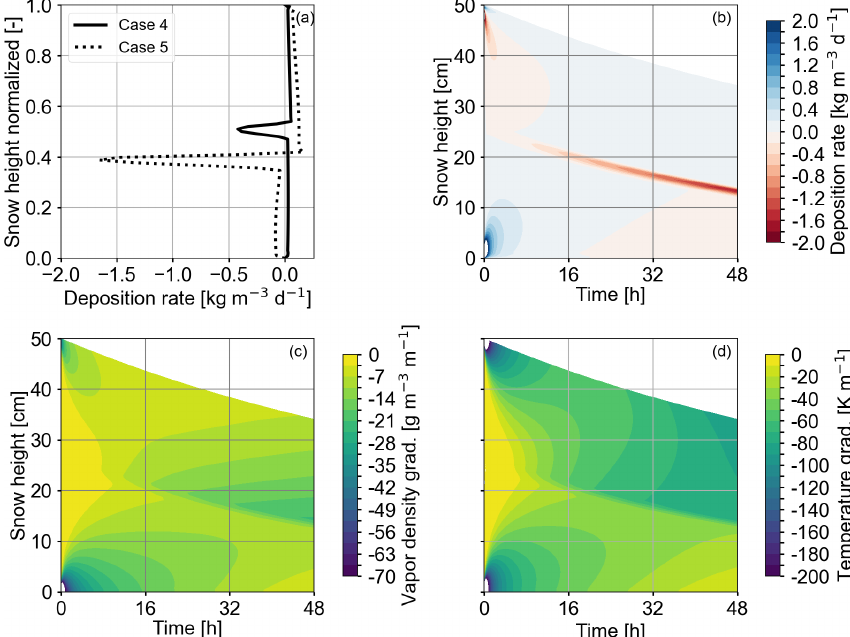
Figure 7. Panel (a) shows two deposition rate profiles over the normalized snow height after 2d. The solid line represents the results of heat and vapor transport in the absence of settling for Case 4 of Table 2. The dashed line refers to Case 5 of Table 2, which additionally accounts for settling. Sublimation rates (negative deposition rates) for Case 5 (fully coupled processes) are increased by approximately a factor of 4 with respect to Case 4 without settling. At the top of the sublimation peak for both cases, a slight peak in the deposition rate is visible. Panel (b) shows the deposition rate profile evolution for Case 5. A pronounced sublimation rate peak in the transition area is first visible after approximately 6h and increases with time. We interpret this area of increased sublimation (red line in the center) as the boundary of the upper and lower layer. Panel (c) shows the evolution of the vapor density gradient. The gradient at the bottom of the upper layer (at approximately 20 and 15cm height after 16 and 48h) increases with time. Panel (d) shows the evolution of the temperature gradient with time. Overall the temperature gradient is higher in the upper compared to in the lower layer. The lobes at the top and bottom at the start of the simulation in (b–d) are due to the strong phase change activity and heat flux triggered by the initial and boundary